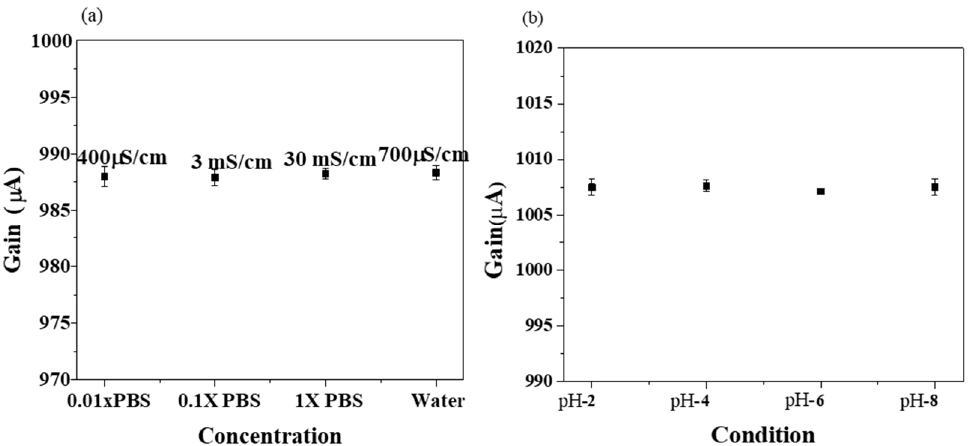
Figure 2. Characteristics of Mercury ion selective ISMFET (Hg-ISMFET). ( a ) Current gain signal of Hg-ISMFET for differing conductivity of test sample. ( b ) Current gain signal of Hg-ISMFET for differing pH of a test sample.